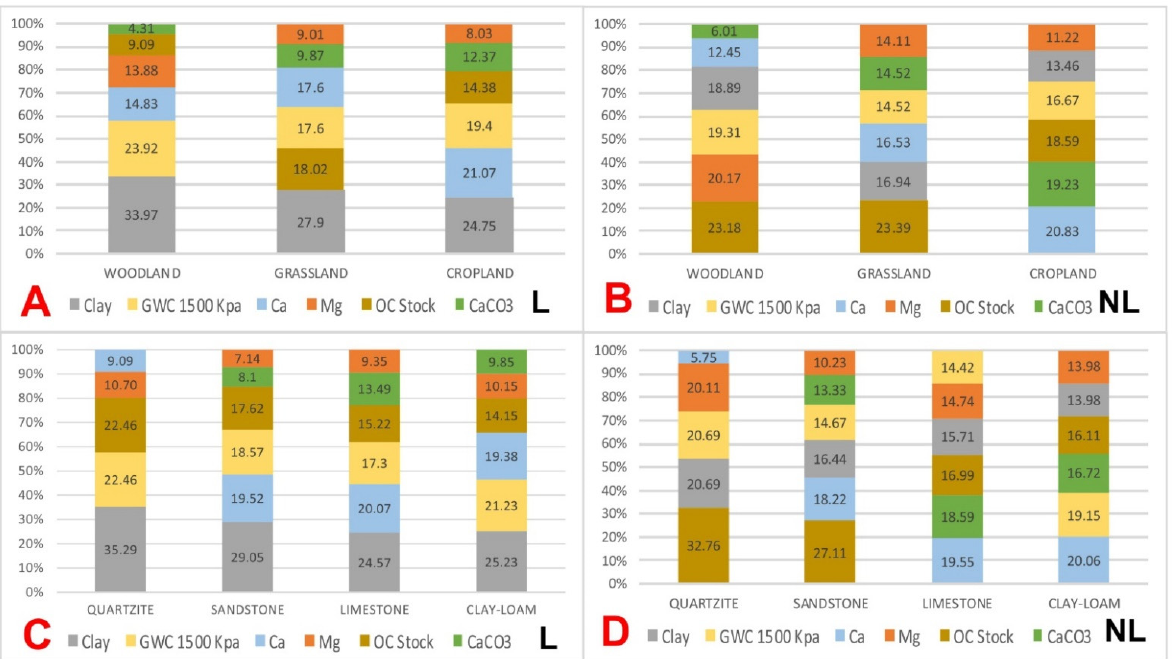
Figure 11. Estimation of the contribution of minimum data set (MDS) indicators to the soil quality index (SQI) (water retention at soil field capacity (GWC1500 kPa), clay content (Clay), organic carbon stock (OC Stock), calcium carbonate equivalent content (CaCO 3 ) and calcium and magnesium (Ca) and (Mg) extractable bases content), using linear ( A , C ) and nonlinear ( B , D ) scoring functions, for the different uses and parent rocks of the soils.